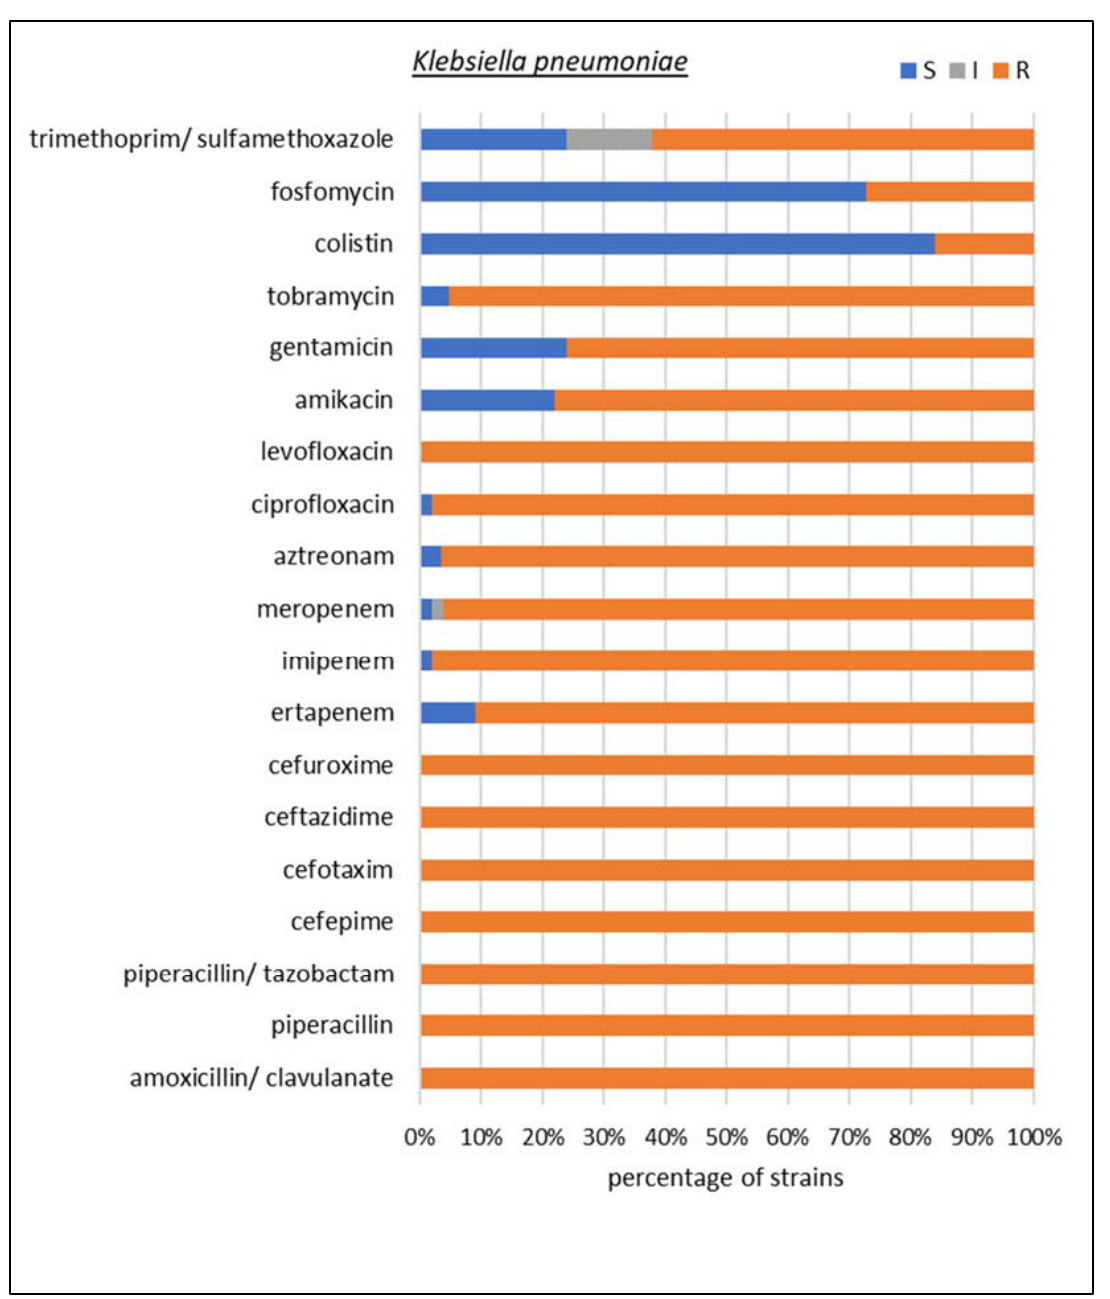
Figure 5. Drug susceptibility of the studied Klebsiella pneumoniae strains producing carbapenemases ( n = 50).